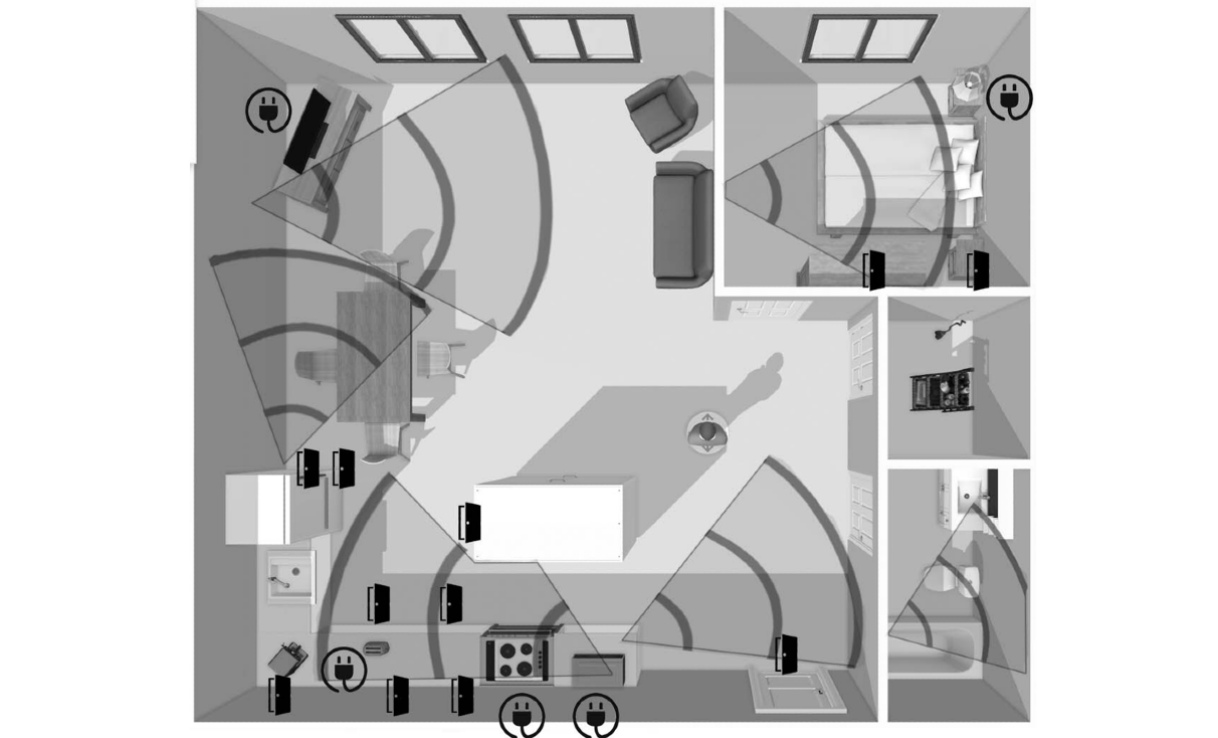
Figure 1. Sketch of the placement of sensors in Lisette’s apartment. Conic area: passive infrared motion sensors; door symbol: magnetic contact sensors; electric plug symbol: smart electric